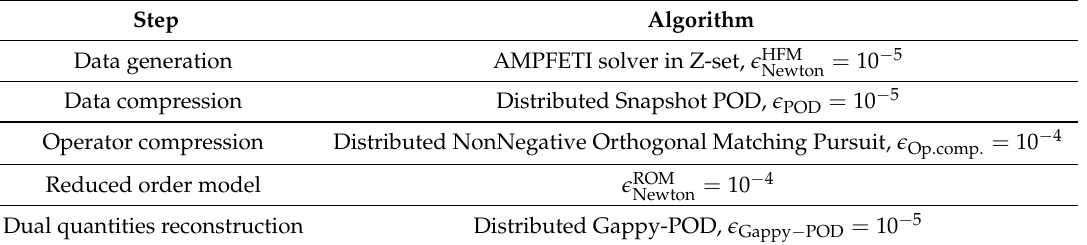
Table 6. Description of the computational